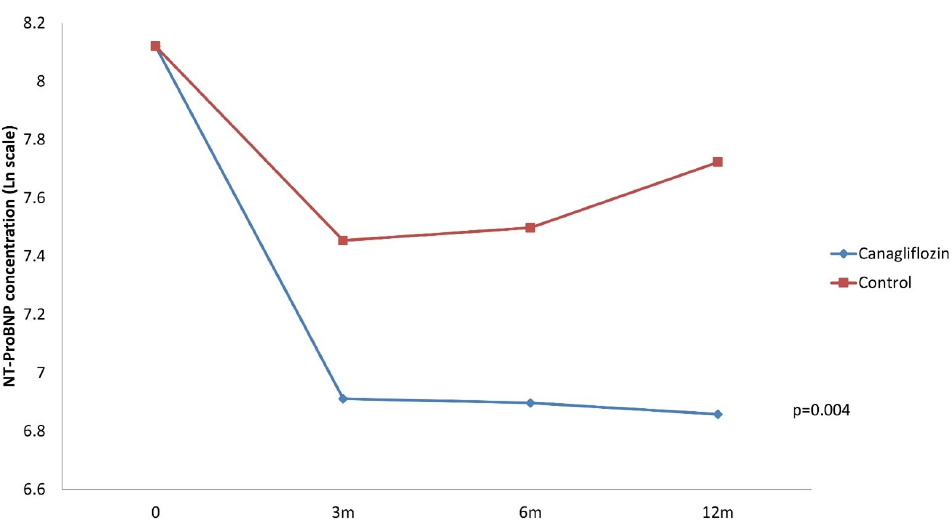
Figure 3. Changes in NT-ProBNP concentration during follow-up. Repeated measures ANOVA analysis adjusted for sex, age and NT-ProBNP concentration at